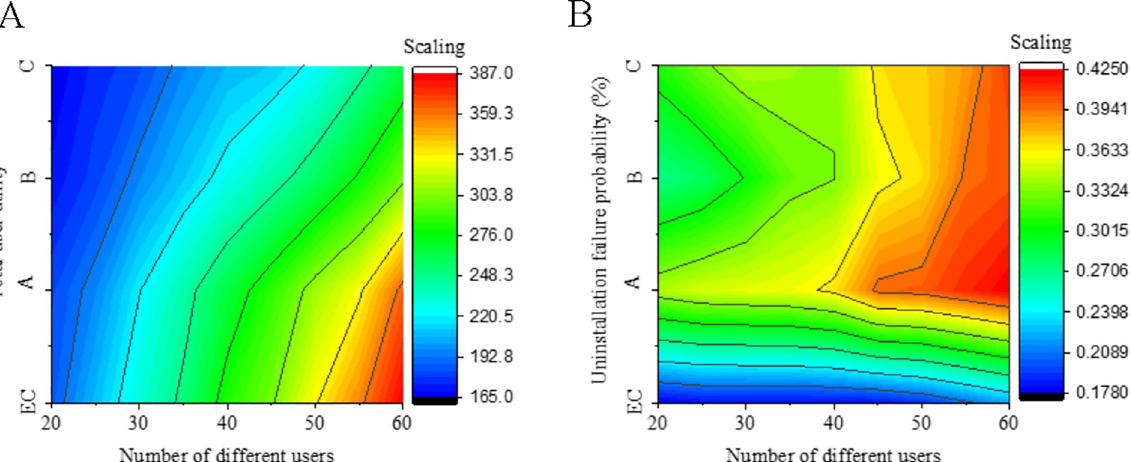
Fig 8. User utility and uninstallation failure under different